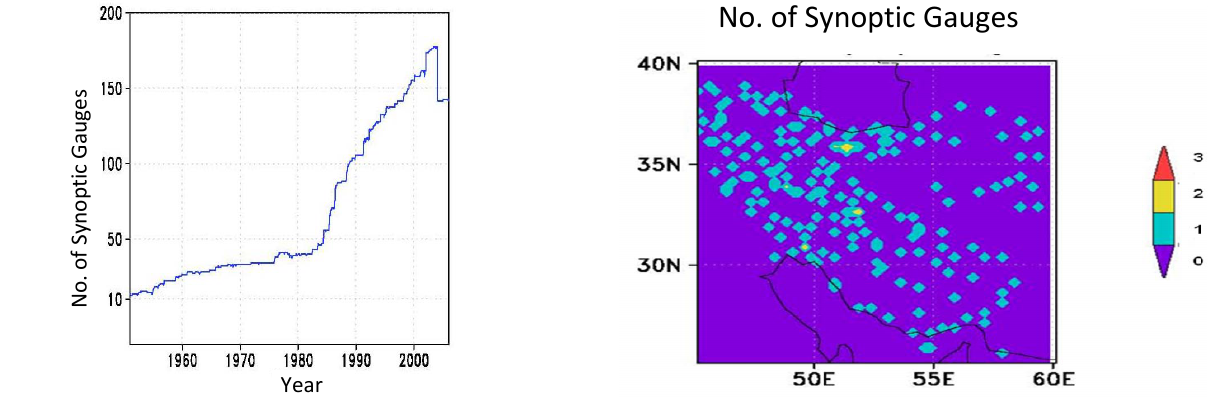
Fig. 3. Time series of the number of synoptic gauges used in this study.